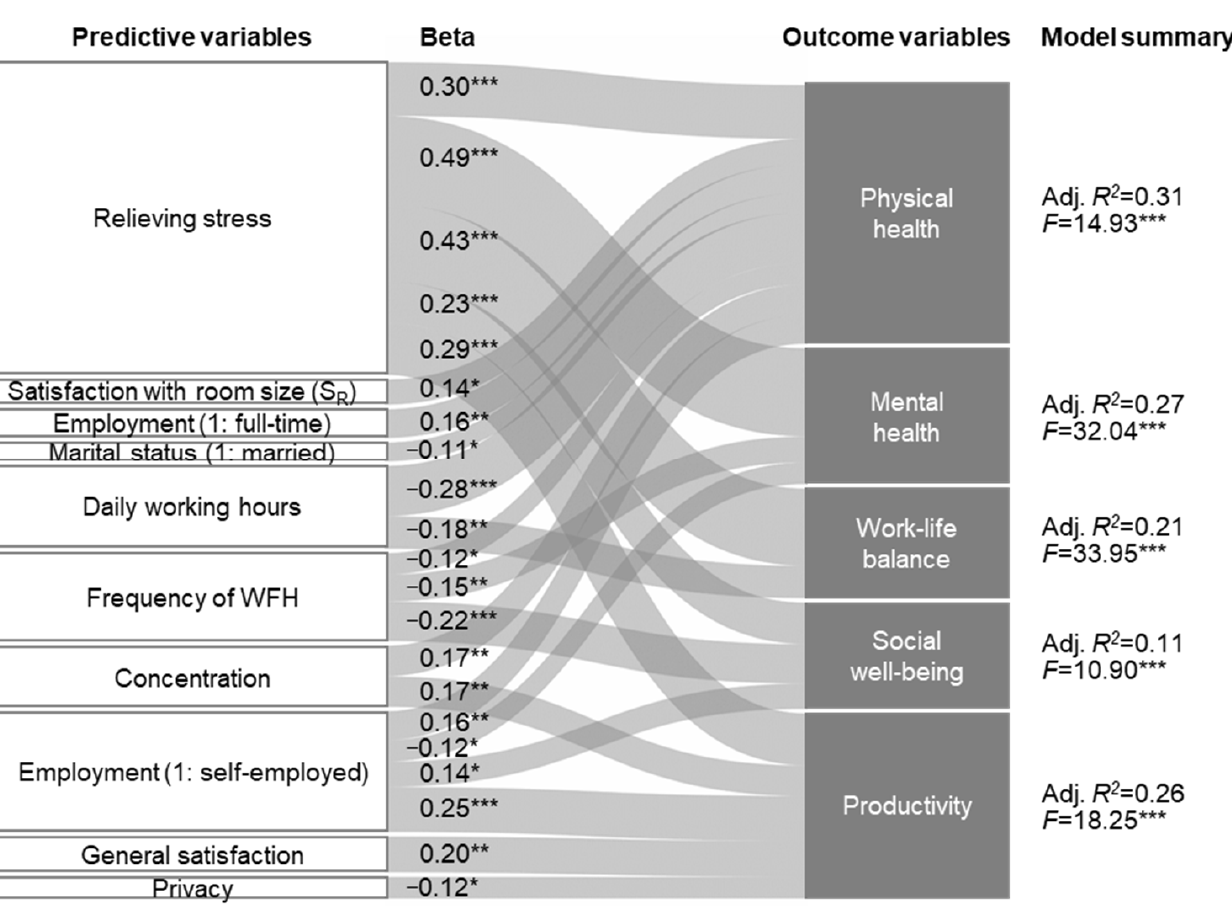
Figure 3. Regression models predicting changes in health and productivity (* p < 0.05, ** p < 0.01, *** p < 0.001).